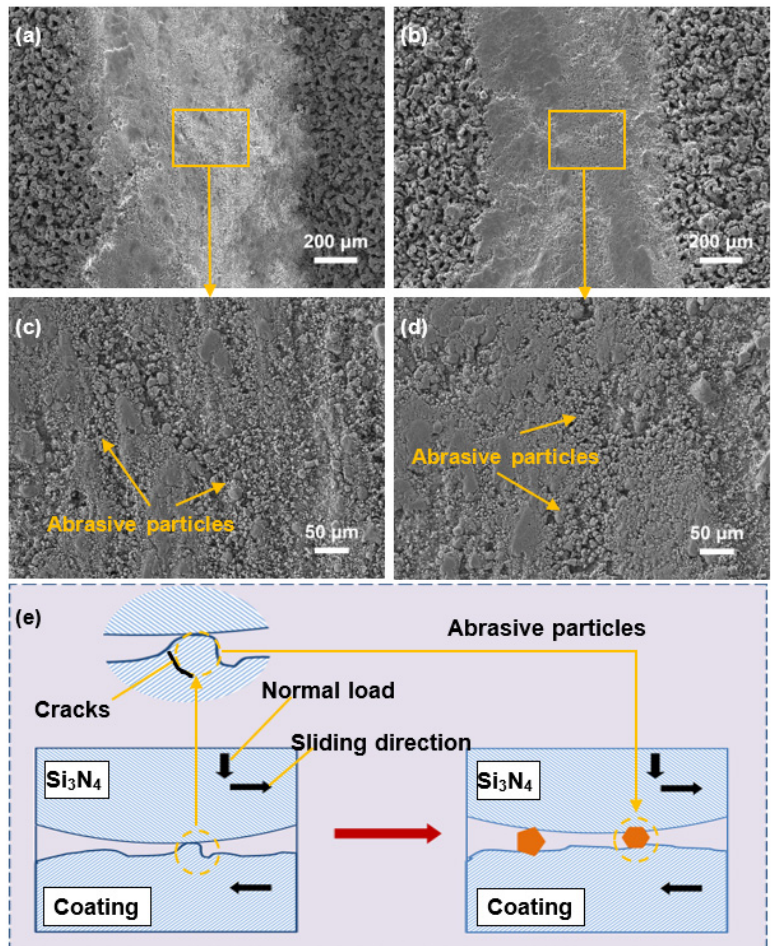
Figure 12. SEM morphologies of wear tracks of CPED coatings and schematic diagram of wear process: ( a ) wear tracks of sample S0; ( b ) wear tracks of sample S15; ( c ) high-magnification image of ( a ); ( d ) high-magnification image of ( b ); ( e ) schematic diagram of wear process of coating.